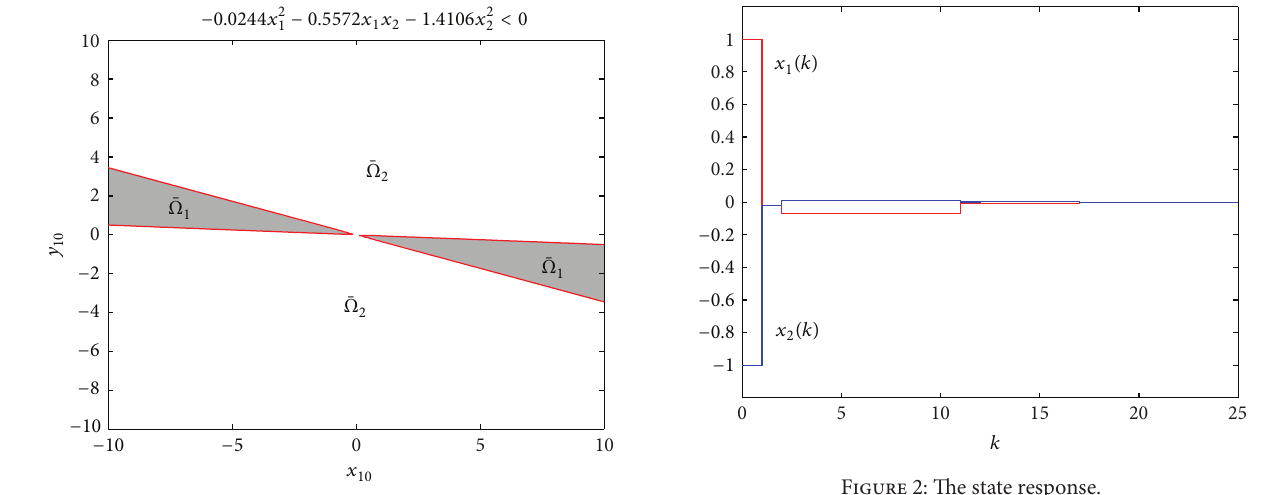
Figure 2: The state